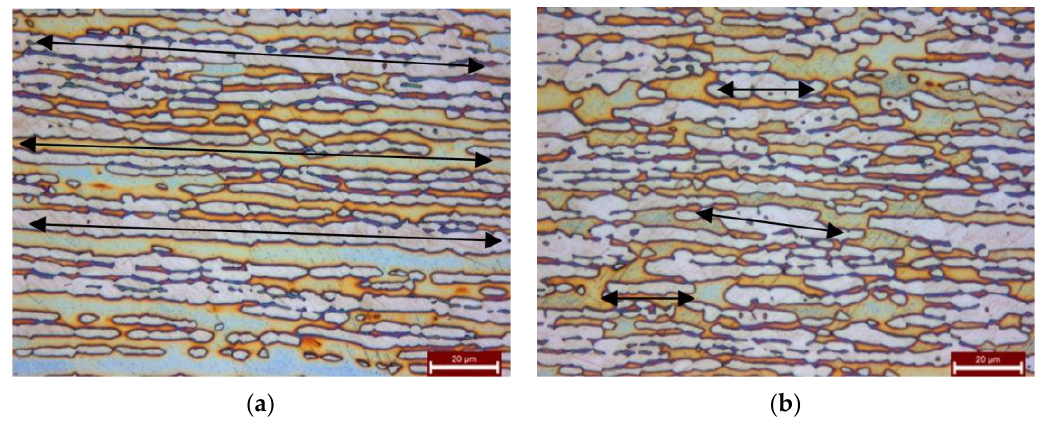
Figure 5. Longitudinal ( a ) and transverse ( b ) micrographs of raw S32205 duplex stainless steel plates (20 µm scale-500×).